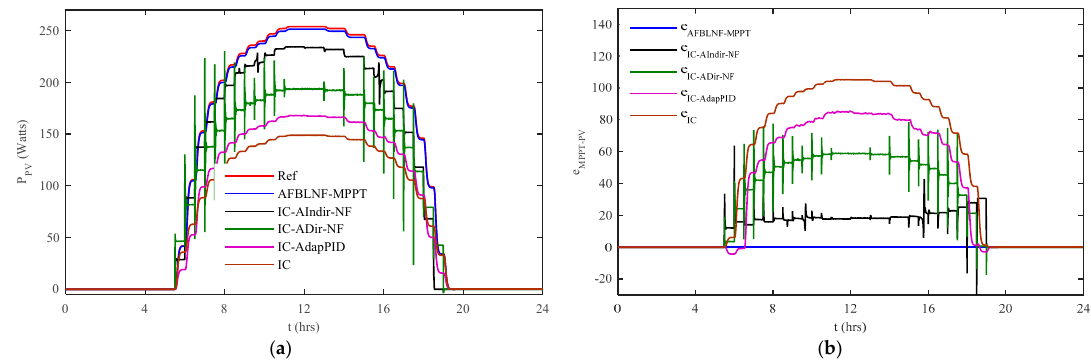
10 of 16 Figure 4. Load vs. generated powers of all sources. SC: super-capacitor; SOFC: solid oxide fuel cell; MT: micro-turbine; CS: charging station; Bat: battery; Elz: electrolyzer. The maximum pobatwers extracted by the PV subsystem using AFBLNF-MPPT, IC-AIndir-NF, IC-ADir-NF, IC-AdapPID, and IC are shown in Figure 5a. The AFBLNF-MPPT acquires the PV